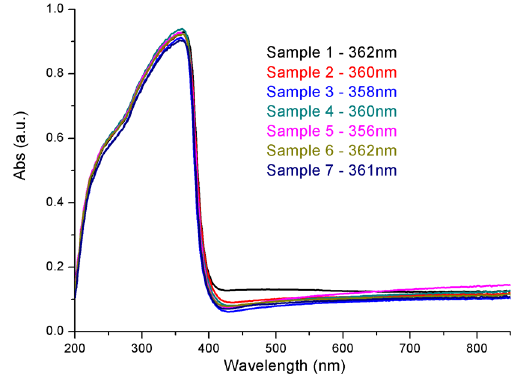
Figure 6. UV-Vis spectra of ZnO obtained in ionic liquids media. Figure 7. Kubelka-Munk function vs . energy plots for ZnO obtained